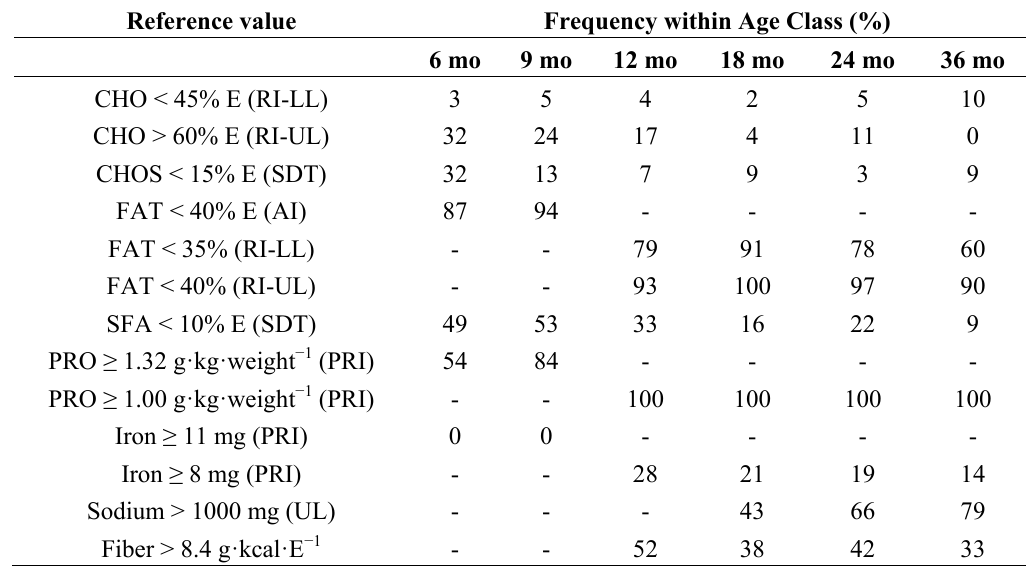
Table 8. Nutrient intake of the NI636 children compared with Italian reference values ( n = 390). Reference